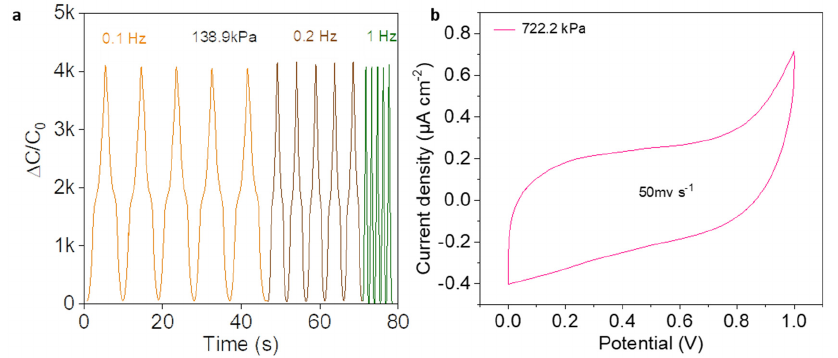
Figure 5. ( a ) Capacitance variation of the sensor under various frequencies. ( b ) CV curve of the sensor at a scan rate of 50 mV s − 1 .